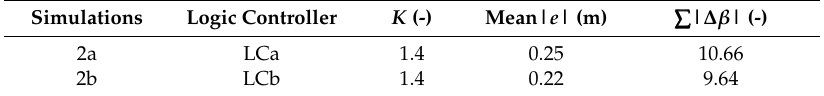
Table 2. Results of simulations 2a and 2b related to scenario 2 (variable speed pump), in terms of mean |e| and ∑ | ∆ β | for the optimal value of K . LCa (logic controller a); LCb (logic controller b).